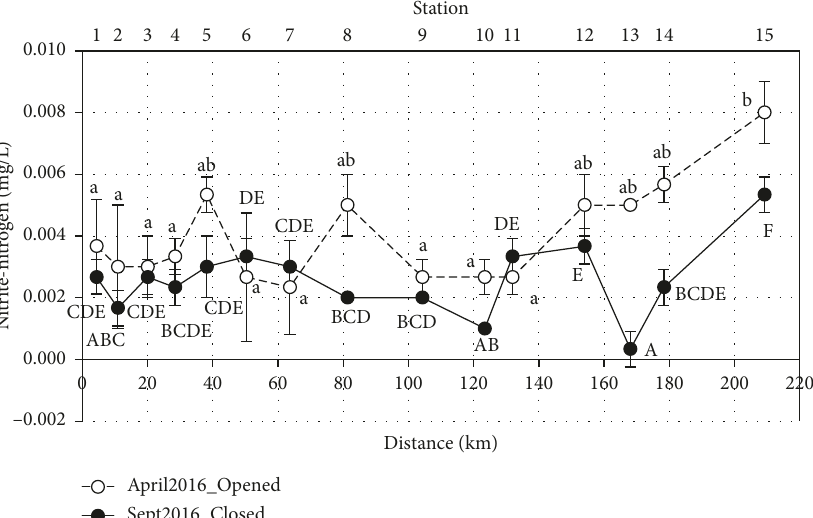
Figure 11: Nitrite-Nitrogen at the 15 stations downstream of Bakun Hydroelectric Dam during opened spillway ( o ) and closed spillway ( • ). The same letter indicates no significant difference ( p > 0 . 05). Table 5: Water quality parameters of the present study compared with the values before building the Bakun Dam [30]. Before building Values of the present study Values of the present study Parameters the dam (closed spillway) (opened